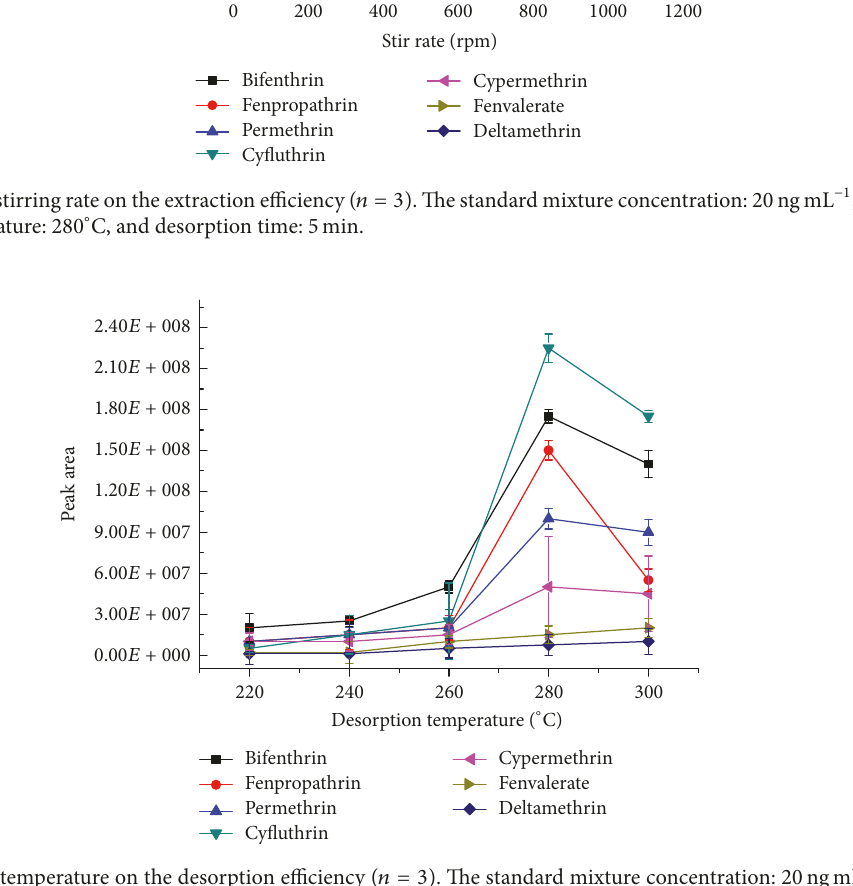
Figure 5: The effect of the temperature on the desorption efficiency ( 𝑛 = 3 ). The standard mixture concentration: 20 ng mL −1 , stirring rate: 750 rpm, extraction time: 20 min, and desorption time: 5